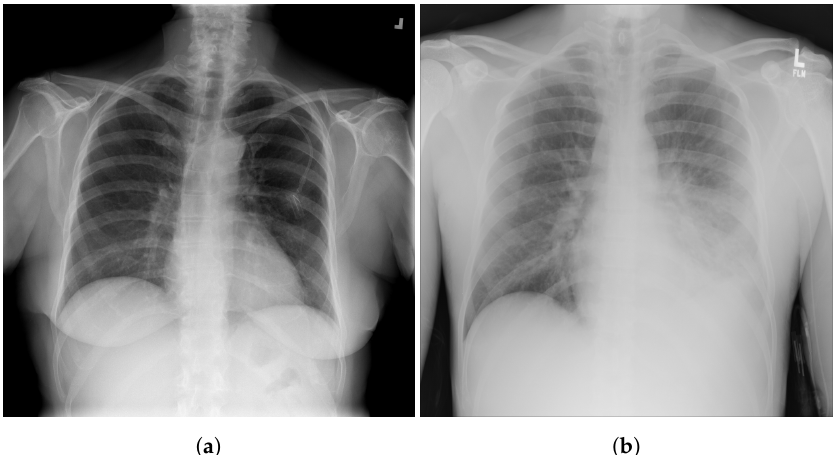
Figure 12. Examples of NIH images. ( a ) No findings (normal); ( b ) patient with pneumonia